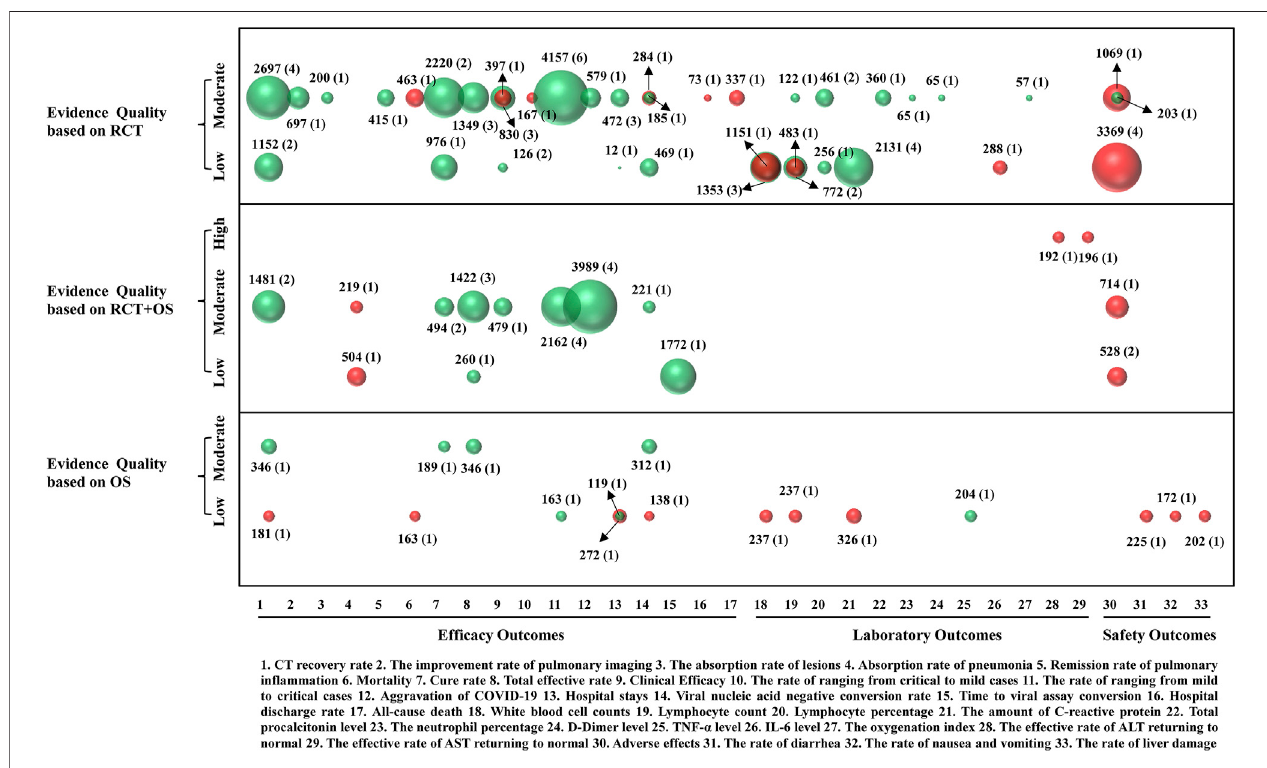
FIGURE 5 | Mapping of evidence quality of ef fi cacy, laboratory, and safety outcomes. Each bubble size represented patients included in the SRs, green color represented p < 0.05,andredcolorrepresented p > 0.05.Theoutcomeswererepresentedonthelateralaxis,andtheevidencequalityofoutcomewasrepresentedonthe vertical